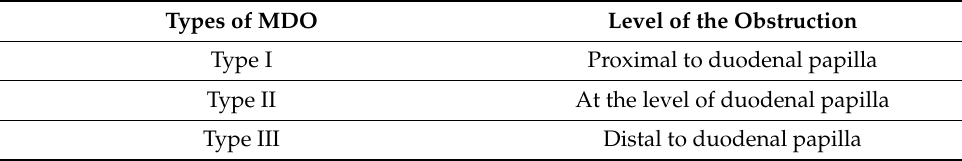
Table 1. Types of malignant duodenal